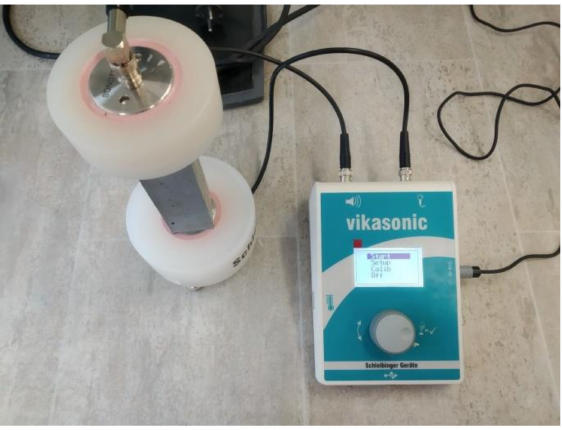
Figure 3. Measurement of the dynamic elastic